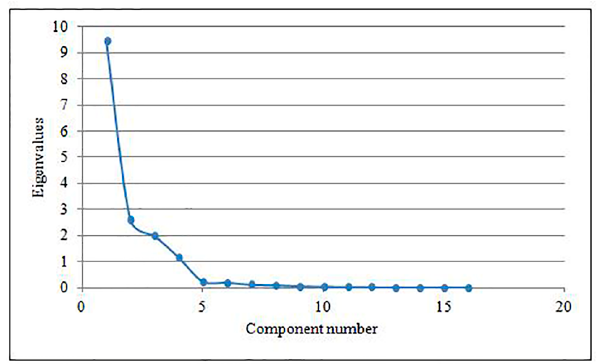
Figure 9. Scree graph of PCA on 16 texture features. Table 5. Eigenvalues and variance percentage of PCA on the all 20 bands.